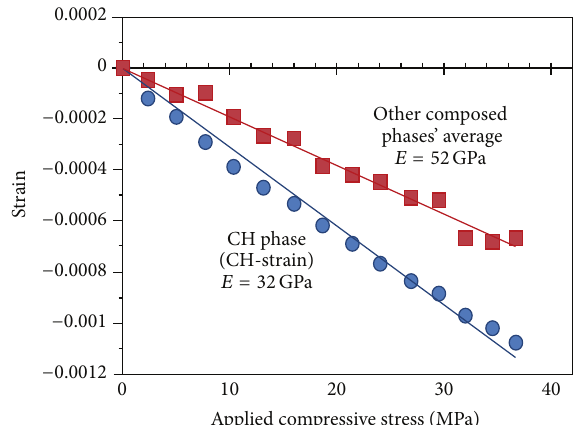
Figure 2: Strain change of the CH phase and the average strain of the other composed phases as a function of the applied compressive stress. The strains are derived from the Bragg peak shift. The average error bars are ±3.4×10 −5 and ±2.1×10 −4 , respectively. The lineally approximated lines are presented in solid